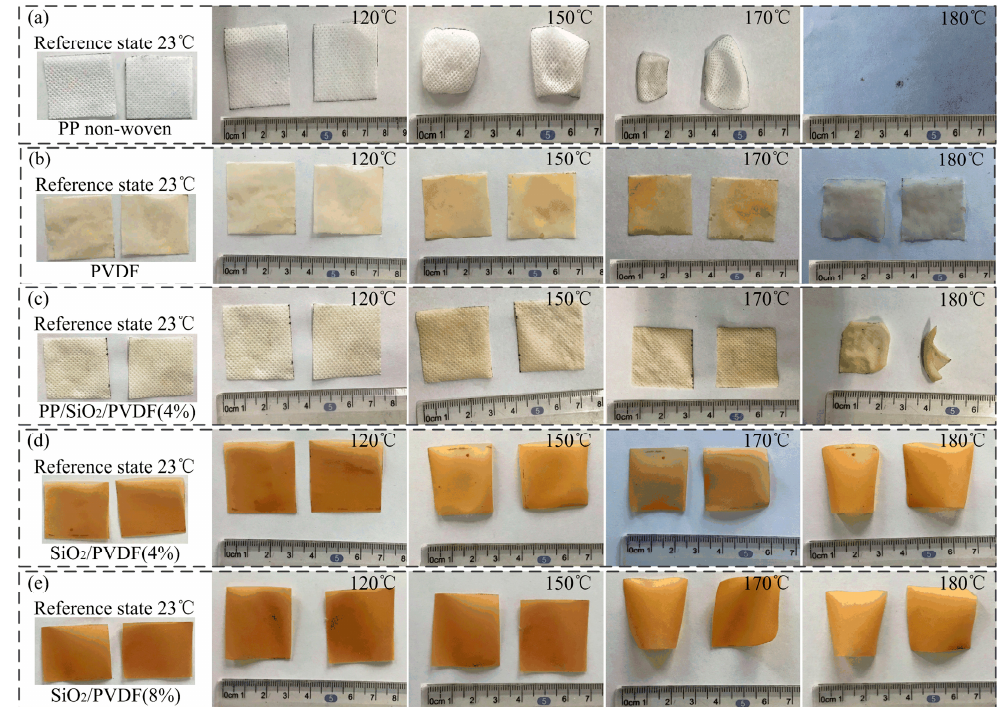
Figure 5. Thermal shrinkage properties of the film: ( a ) thermal shrinkage of PP non-woven materials under different heat treatment temperature; ( b ) PVDF; ( c ) PP/SiO 2 /PVDF (4%); ( d ) SiO 2 /PVDF (4%) and ( e ) SiO 2 /PVDF (8%).